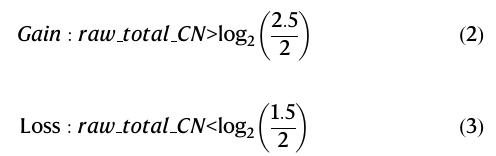
or RAS pathways based on the Reactome de fi nition. The boxplots (right panel) show, for both PI3K/RAS and other cancer genes, the difference between the fre- quency of cancer genes SCNAs in tumours with and without MYC ampli fi cation or gain. The p -value of the one-sided permutation test of equality of means is indi- cated.Alistof knowndrivergenesisalsopresented acrossallplots – thegenesare highlighted inyellow ifthey are recognisedGISTIC driversin each speci fi ctumour. For all boxplots ( a , b and c ), the central box was de fi ned by the quantiles 0.25, 0.5 and 0.75 of the data, and the maximum whisker size equals 1.5 times of the inter- quartile range (inference without multiplicity